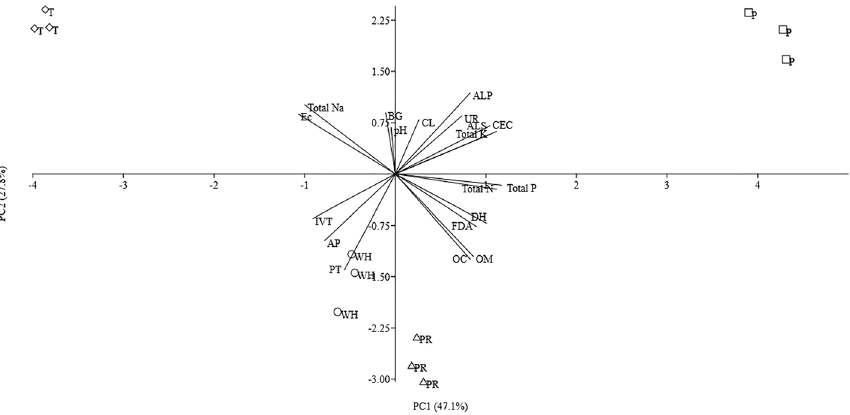
Figure 3. Principal component analysis (PCA) of soil enzyme activities and soil chemical characteristics under saline rhizosphere soil of ‘RD 6’ rice. Relationships between soil enzyme (CL: cellulase, BG: β-glucosidase,